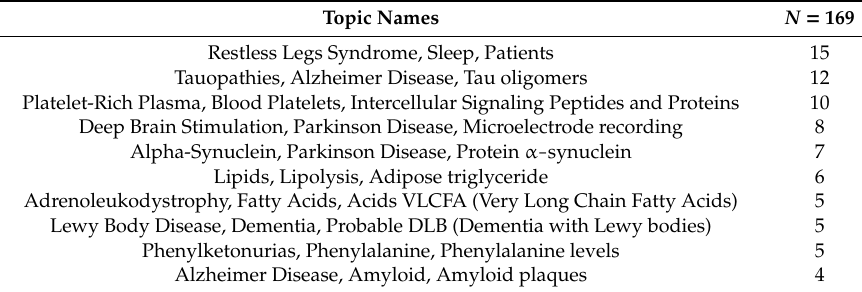
Table 10. Alzheimer Disease. Cluster (19), weigh 5.84%.